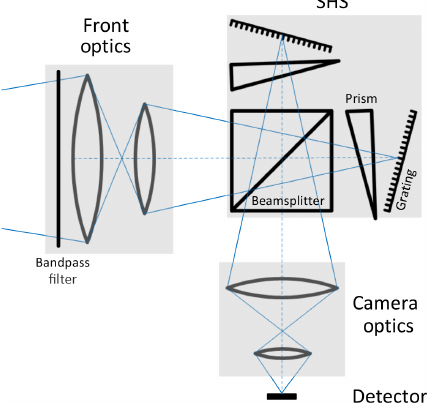
Figure 3. Basic design of the SHS with front and detector